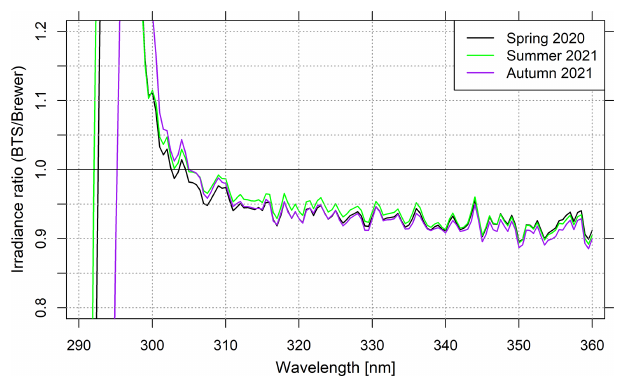
Figure 2. Average spectral ratios obtained throughout the three campaigns.